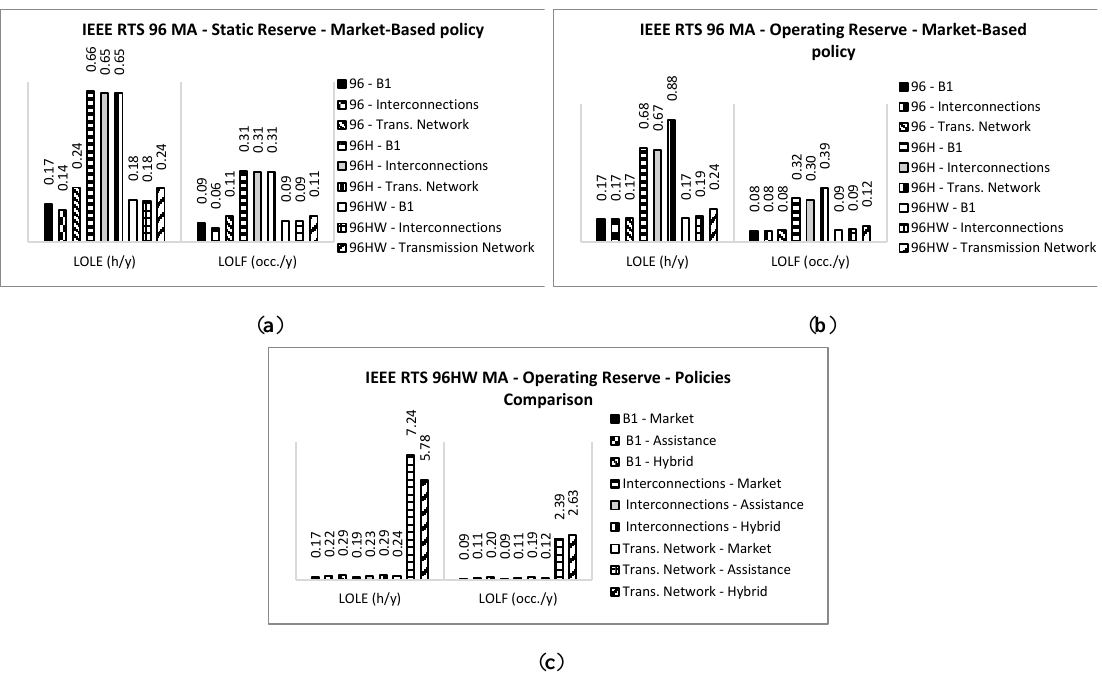
Figure 5. Results for different multi-area system representations. ( a ) IEEE RTS 96 MA Static Reserve; ( b ) IEEE RTS 96 MA Operating Reserve; IEEE RTS 96 HW MA Policies Comparison. Table 2. Interconnection